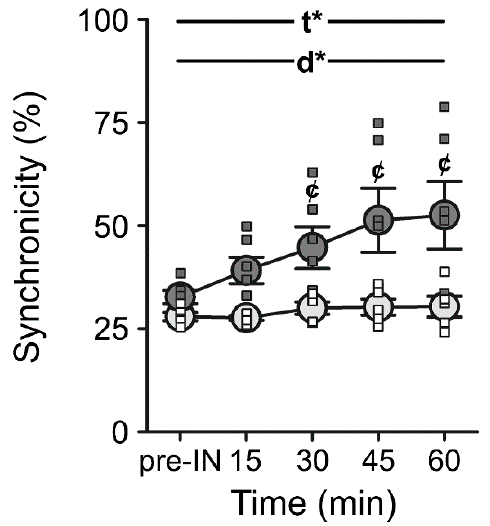
Figure 3. Analysis of the S1 neuronal Ca 2+ network in response to intranasal saline (INS) or INI in aged F344 animals. Measures of synchronicity were derived from a correlation matrix across ~1000 neurons in each group. Main effects of both time following intranasal delivery (2-way ANOVA; F (1.36,12.25) = 9.90, p = 0.01) and INI (F (1,9) = 7.43, p = 0.02) were detected. Data represent means ± SEM. Asterisks indicate main effects of time (t*) or drug (d*) at p < 0.05. Cent symbols (¢) denote Bonferroni post hoc significance ( p < 0.05) between INS and INI at the timepoints indicated. Figure reproduced from Lin et al., 2022 [137].